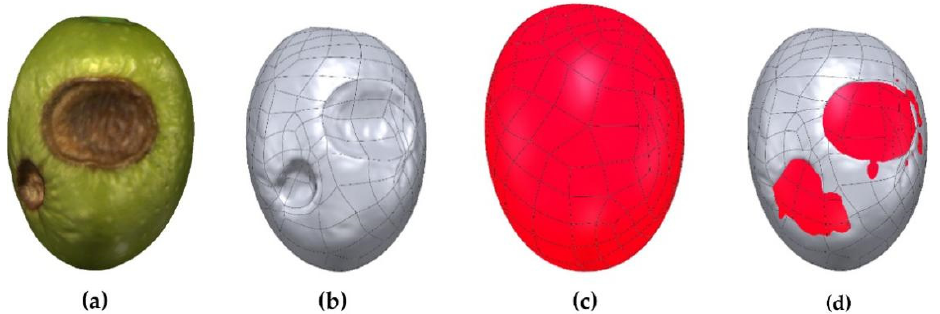
Figure 9. NURBS solid overlay: ( a ) 3D mesh texturing; ( b ) NURBS surfaces real olive; ( c ) NURBS surfaces virtual olive, and ( d ) superposition of ( b , c ).